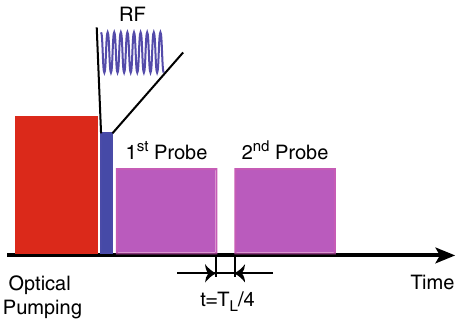
Fig. 4 Pulse sequence for calibration of measurement direction. The RF fi eld pulse between the pump and probe laser pulses creates a transverse spin excitation, rotating in the y - z plane. The fi rst part of probe pulse measures ^ p A . By tuning the phase of the RF fi eld to maximize the fi rst probe signal, we can validate that the transverse spin is in the ^ p A direction (in the rotating frame). If the second probe signal, after a quarter of the Larmor period, is minimal, we verify that the induced spin is in the ^ x A